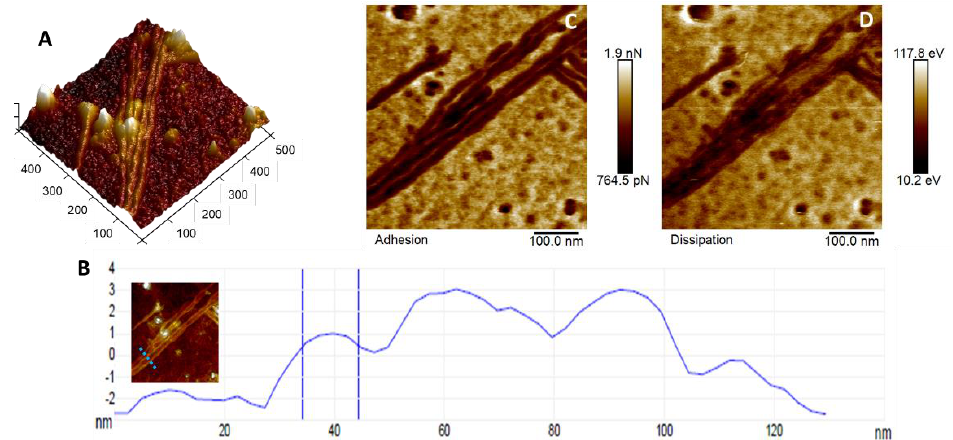
Figure 4. Protein fiber formation: ( A ) 3D height map of the fibers. ( B ) Cross section representing the diameter measurements. The blue dotted line in the inset shows the region from which the cross section was taken. ( C ) Adhesion map demonstrating the contrasts of surface charge of the fibers compared to the substrate, and ( D ) the energy dissipation to assess the viscoelasticity.